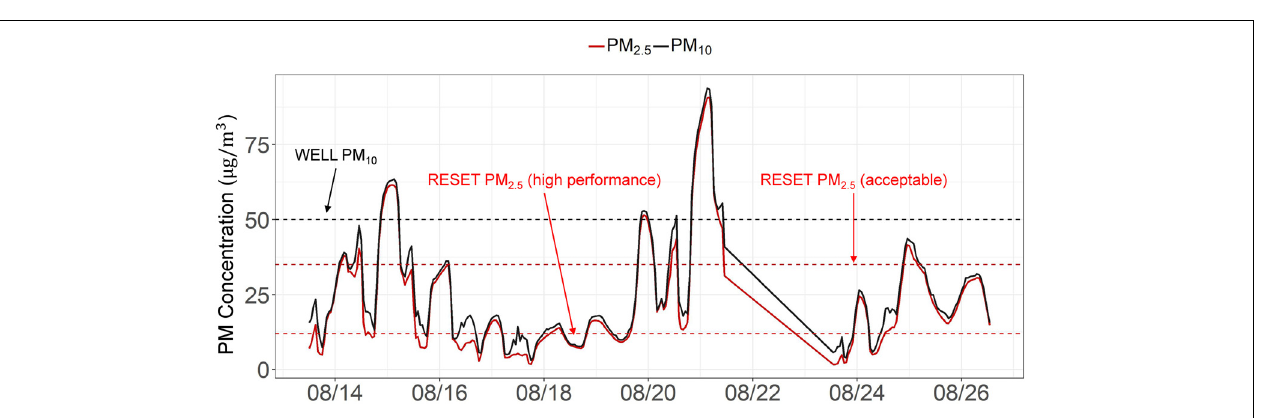
FIGURE 8 | Post-retrofit PM 2 . 5 and PM 10 levels on C3 during smoke days.